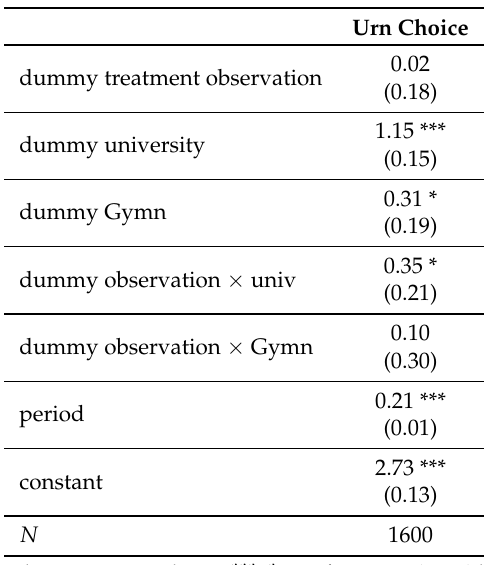
Table 2. Random effect regression: urn